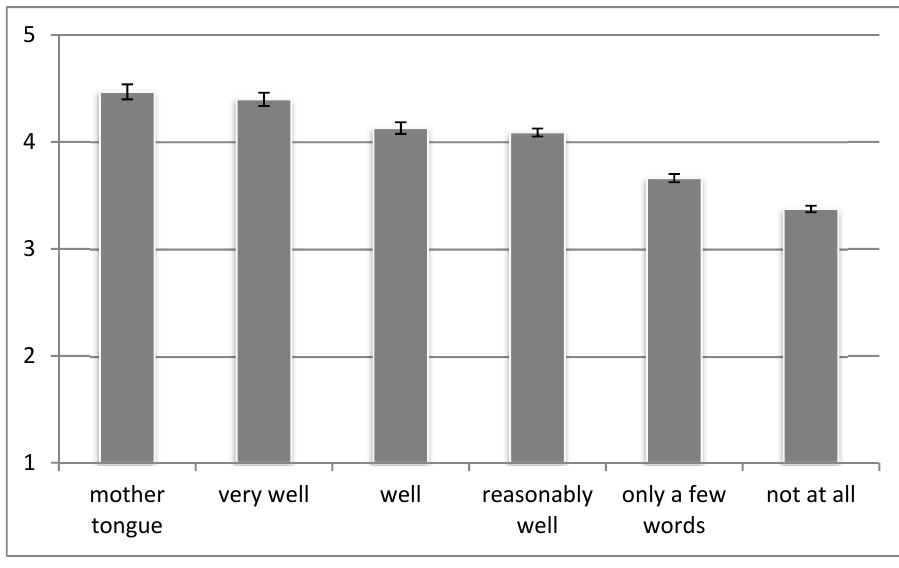
Figure 9. Evaluation of the item “beautiful”/“ugly” for Low German by proficiency in Low German (AToL scale, NGS2016).